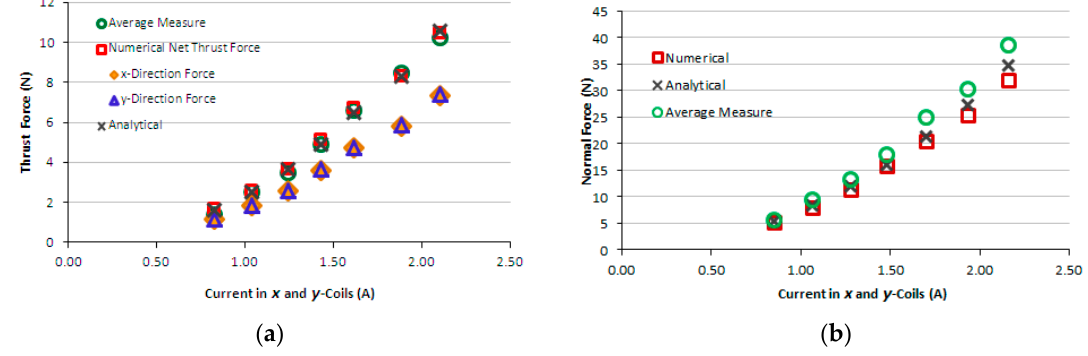
Figure 10. Case 1: ( a ) thrust force and ( b ) normal force produced by the induction planar actuator when both x and y -winding are under current.